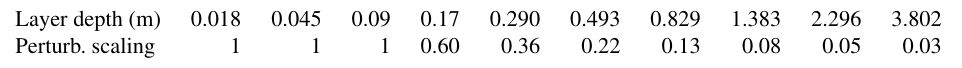
Table 1. CLM soil layer depths and relative layer thickness with respect to the sum of the two top layers. The relative thickness was used as a scaling factor for the soil perturbations, effectively decreasing ensemble spread and error covariance for lower